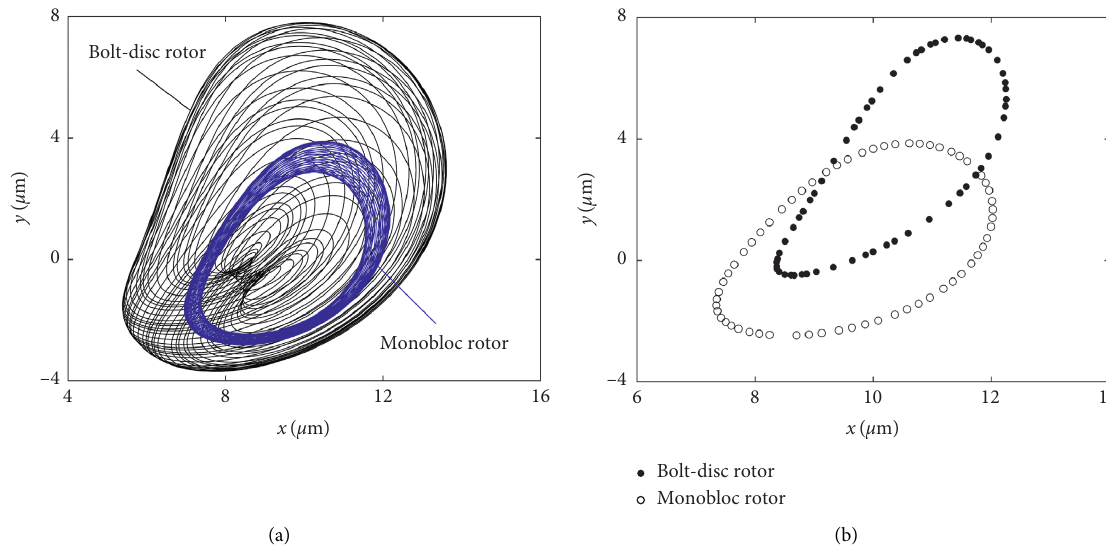
Figure 10: Whirling motions of the both imprecise rotors with position error at the bearing “k”: (a) rotor orbits at bearing “k” and (b) correspondent Poincar´e map.